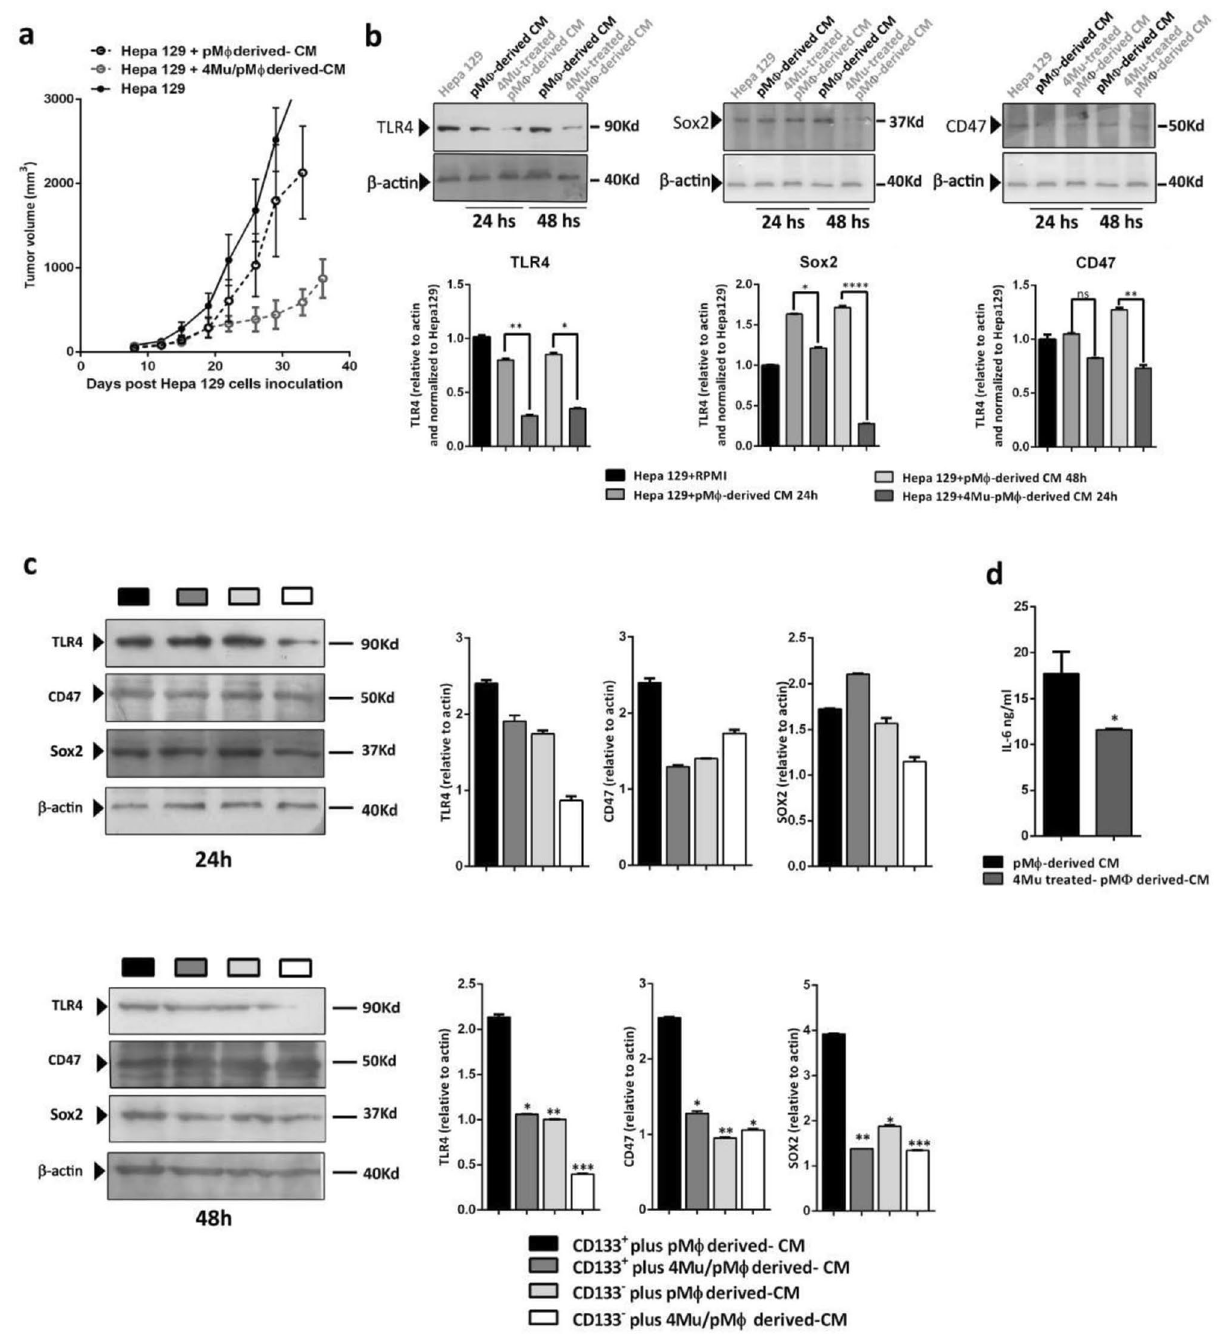
Figure 3. M1 type macrophages induced by 4Mu ameliorate hepatocellular carcinoma aggressiveness. ( a ) Hepa129 cells were incubated for duplicate with RPMI (Hepa129 + RPMI), CM from isolated pM -derived CM), and CM from isolated pM in vitro treated with 4Mu (Hepa129 + 4Mu-treated ϕ (Hepa129 + pM pM -derived CM) for 48 h. Pre-conditioned 1 × 10 6 Hepa 129 cells were injected s.c. in C3Hj mice (n = 4/ ϕ ϕ group), and tumor volume was measured. ( b ) Hepa129 cells were cultured with RPMI, pM -derived CM ϕ and 4Mu-treated pM -derived CM, and the expression levels of TLR4, CD47 and Sox2 were analyze by ϕ western blot; different parts from different membranes were delineated with dividing lines. Full-length blots ϕ are presented in Supplementary Fig. 4A **p < 0.05, *p < 0.01 or ****p < 0.001; Kruskal-Wallys test. ( c ) TLR4, CD47 and Sox2 expression was also determined by western blot on magnetic-isolated CD133 + and CD133 - Hepa129 cells cultured with pM -derived CM or 4Mu-treated pM -derived-CM; different parts from different membranes were delineated with dividing lines. Full-length blots are presented in Supplementary Fig. S4B, ϕ ϕ **p < 0.01CD133 + plus 4Mu-treated pM -derived-CM vs. pM -derived CM; 48hs Kruskal–Wallys test. ( d ) IL-6 production by pM treated or not with 4Mu in vitro by ELISA, *p < 0.05 Unpaired T test; Data are expressed as ϕ ϕ the mean ± SEM. The in vivo and in vitro experiments were carried-out 2 ϕ